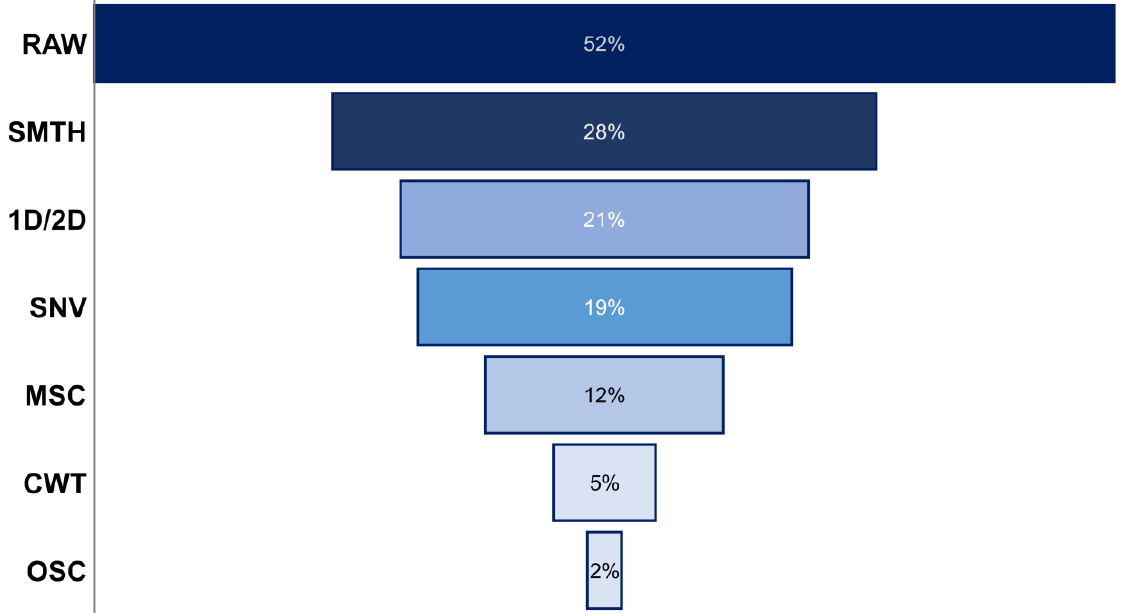
Figure 4. Percentage of studies in the last 6 years that applied each preprocessing method for UV-Vis data. Note: SMTH: Savitzky – Golay smoothing; 1D/2D: first and second derivative; SNV: standard normal variate; MSC: multiple scatter correction; CWT: continuous wavelet transforms; OSC: orthogonal signal correction.